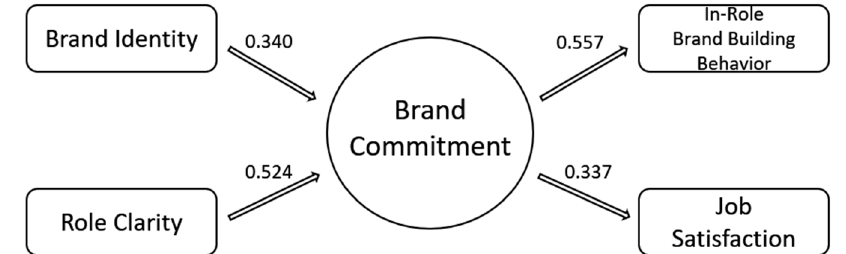
Figure 2. Research model results.